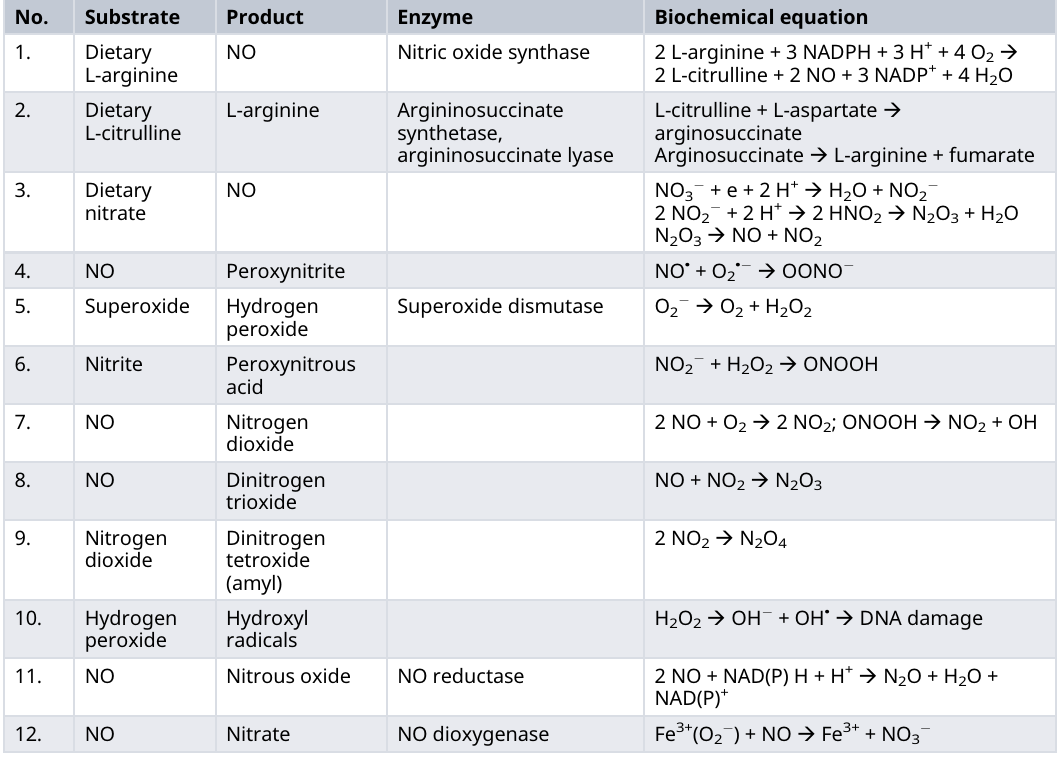
Table 1. Chemical equations relevant to the nitric oxide system.